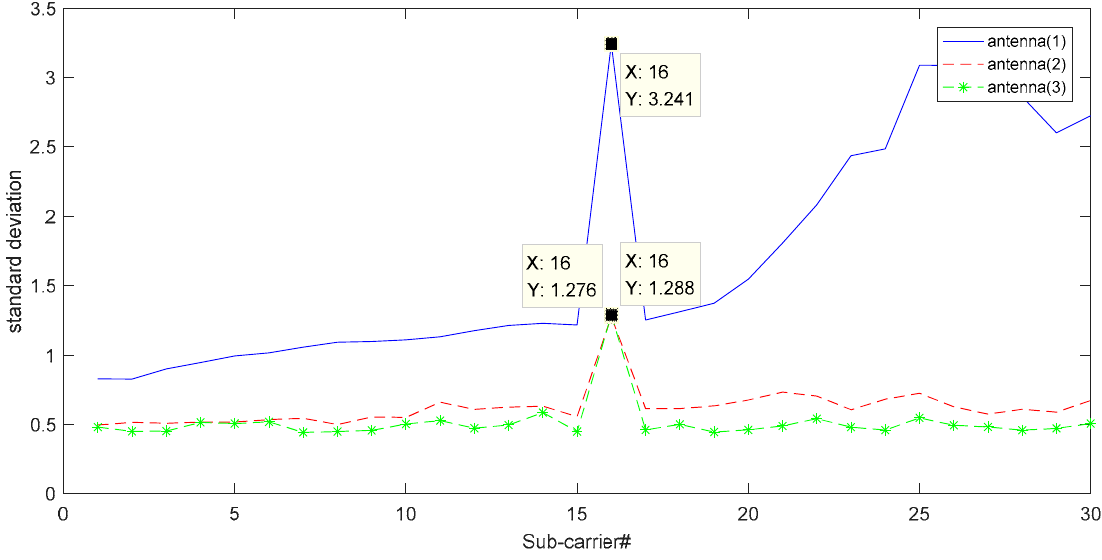
Figure 4. Standard deviation of the subcarriers of the three antennas.